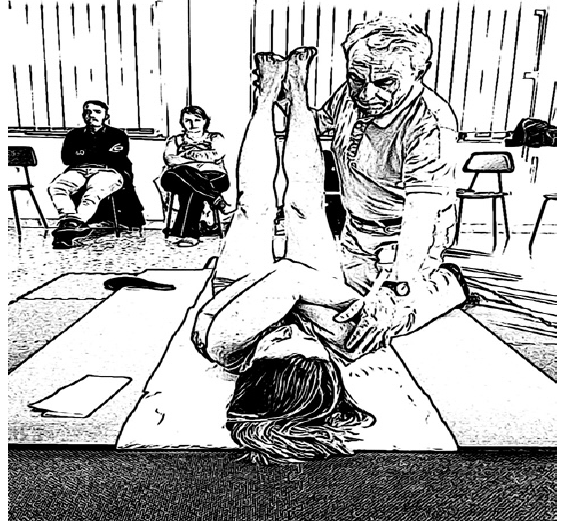
Figure 4. An example of an exercise performed by the physiotherapist during section two of the training. Lumbar stretching according to the Méziéres method.